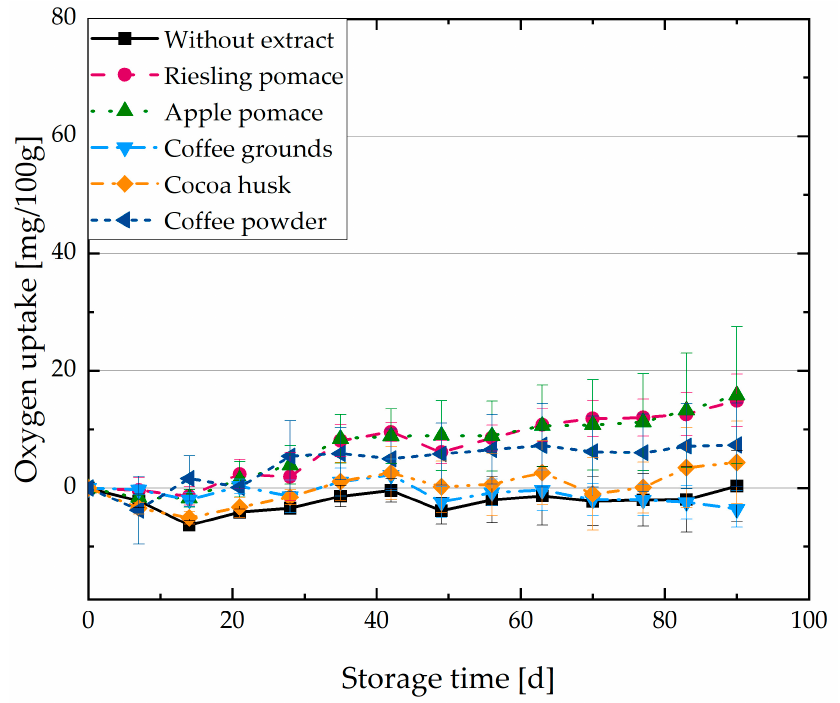
Figure 4. Oxidation kinetics of natural cosmetic emulsions with plant extracts stored in darkness. The figures show the oxygen uptake in mg O 2 per 100 g as a function of the storage time at 30 ◦ C for the O/W emulsions with and without extract, as mean values ( n = 3) with standard deviation (SD).